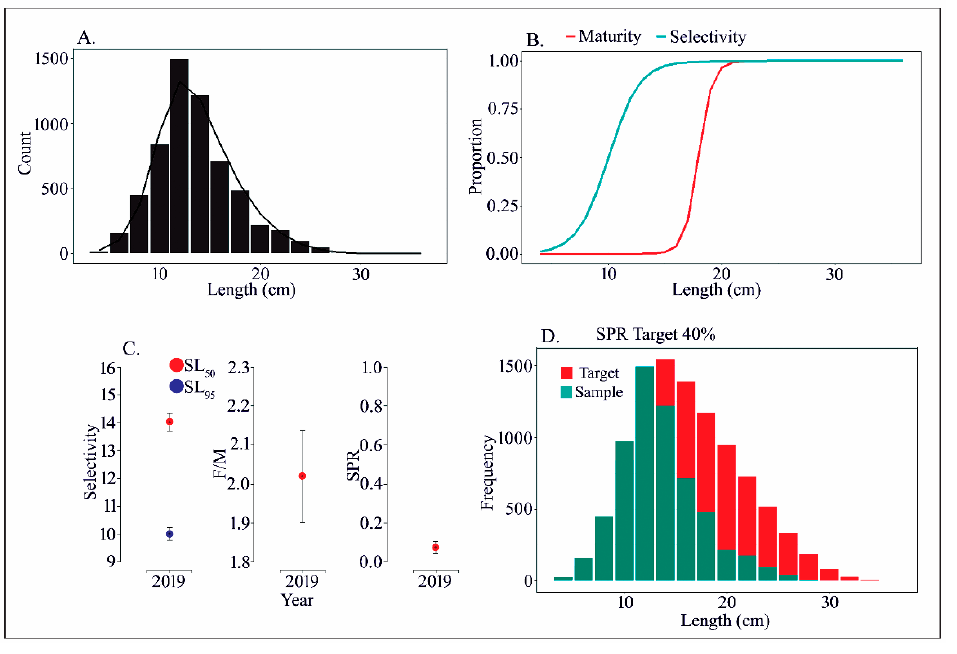
Figure 7. The outputs of the LB-SPR model, showing: ( A ) length–frequency distribution of observed fished population, and the solid black line show the predicted fished size composition from the fitted LB-SPR model; ( B ) maturity and selectivity curve from the fitted LB-SPR model when L 50% = 17.95 cm and L 95% = 19.75 cm; ( C ) shows the distribution of mean selectivity parameters ( SL 50% and SL 95% ), fishing mortality to natural mortality ( F/M ), and spawning potential ratio; ( D ) observed size data against an expected size composition at a target SPR (0.4). Table 5. Outputs form LB-SPR analysis with 95% confidence interval.